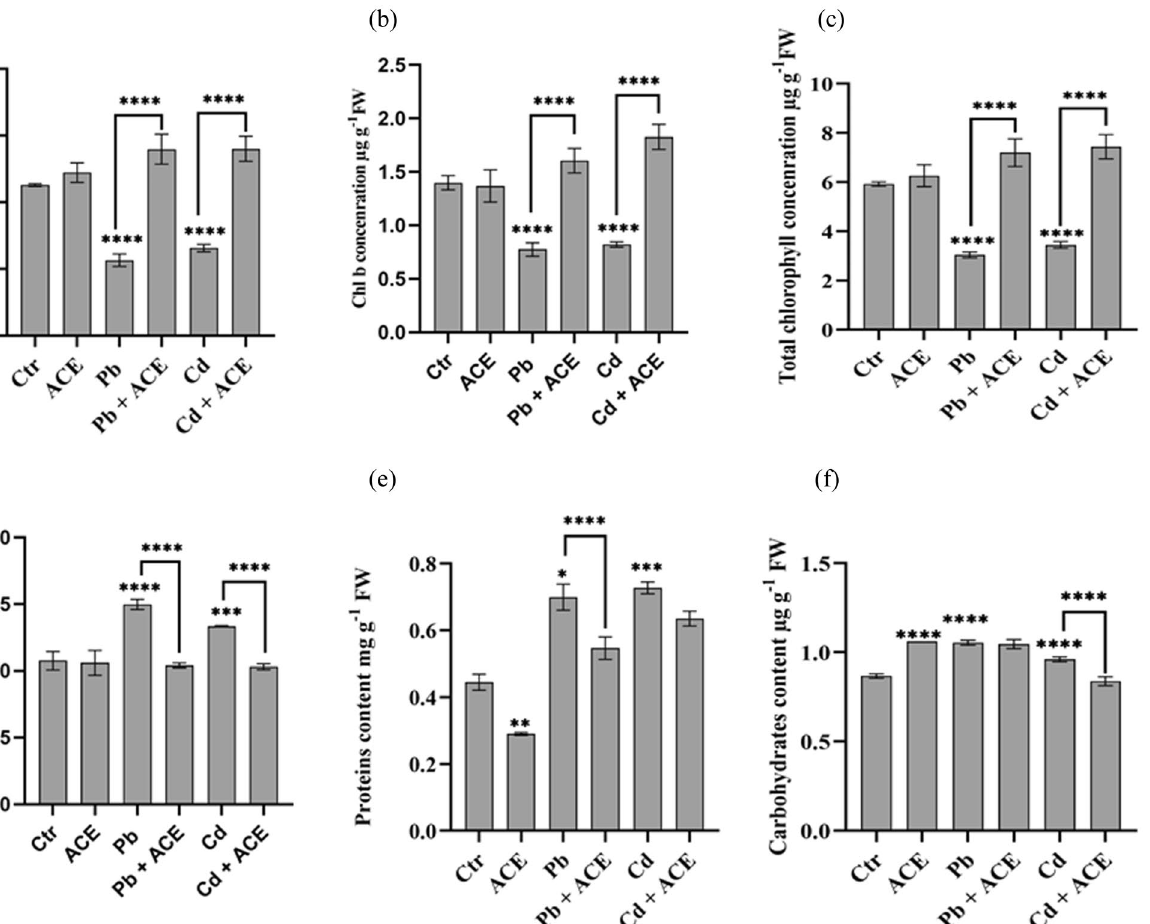
Figure 2. Effect of ACE on tomato leaves photosynthetic pigments ( a ) Chl a, ( b ) Chl b, ( c ) Total Chl and ( d ) Carotenoids and soluble proteins ( e ) and sugar ( f ). [Figure generated by GraphPad prism 9 software, while “*” indicates statistical significance ( P < 0.05); “**” indicates statistical significance ( P < 0.01); “***” indicates statistical significance ( P < 0.001); P “****” indicates statistical significance ( P =